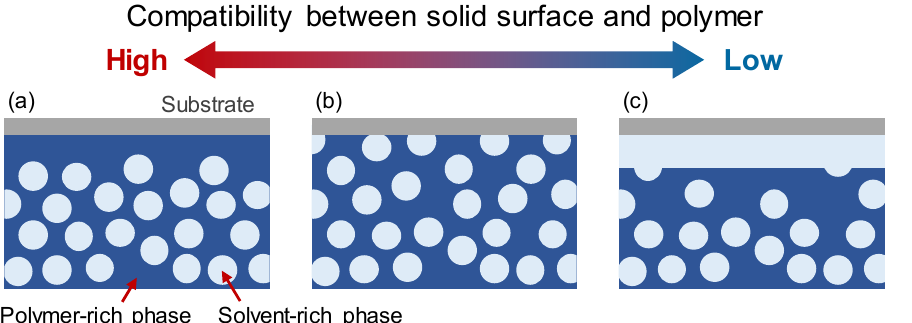
Figure 9. Illustration of surface structure development in cases of solid surfaces with ( a ) high, ( b ) neutral, and ( c ) low compatibility with polymer.